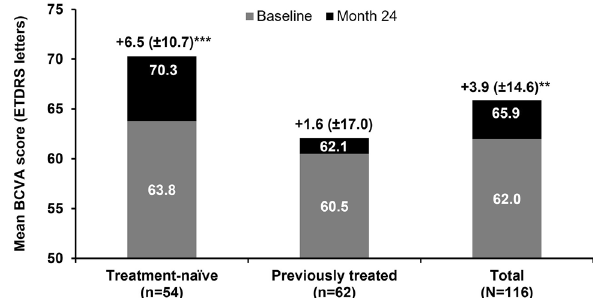
Figure 2. Change in visual acuity for all patients in the FAS with a BCVA assessment at baseline and Month 24, stratified according to treatment cohort. Values above each bar indicate the mean (± standard deviation) change in BCVA letter score from baseline to Month 24. BCVA, best-corrected visual acuity; ETDRS, Early Treatment Diabetic Retinopathy Study; FAS, full analysis set. *** p < 0.001 and ** p < 0.01 for mean change at Month 24 versus baseline (Student t-test).